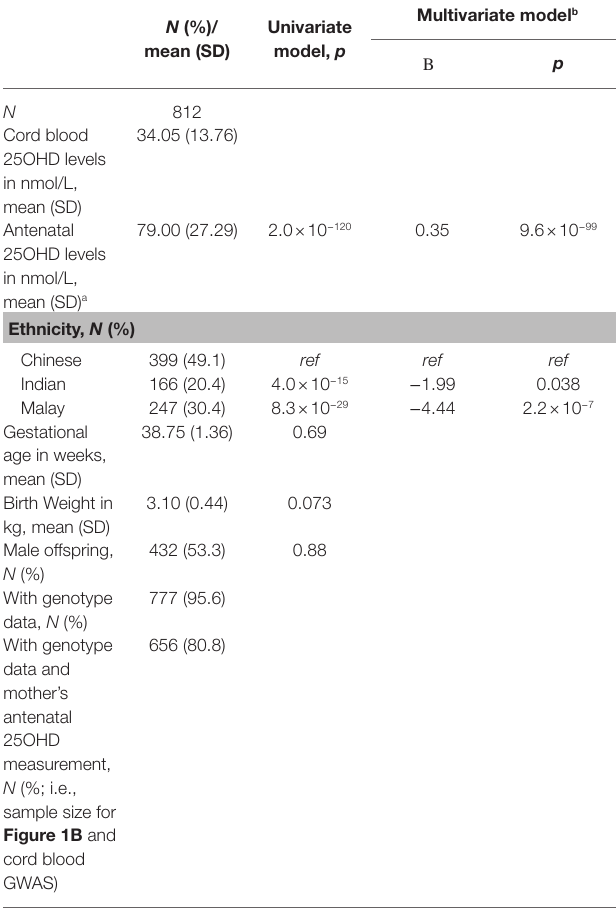
TABLE 2 | Characteristics for cord blood vitamin D levels. concentration of 81.08 ± 27.16 nmol/L ( Supplementary Figure 2 ). Overall, 41% of the mothers had inadequate vitamin D Multivariate model N (%)/ Univariate ( ≤ 75 nmol/L). In a multivariate regression model ( Table 1 ), mean (SD) model, p low concentrations of antenatal vitamin D strongly associated